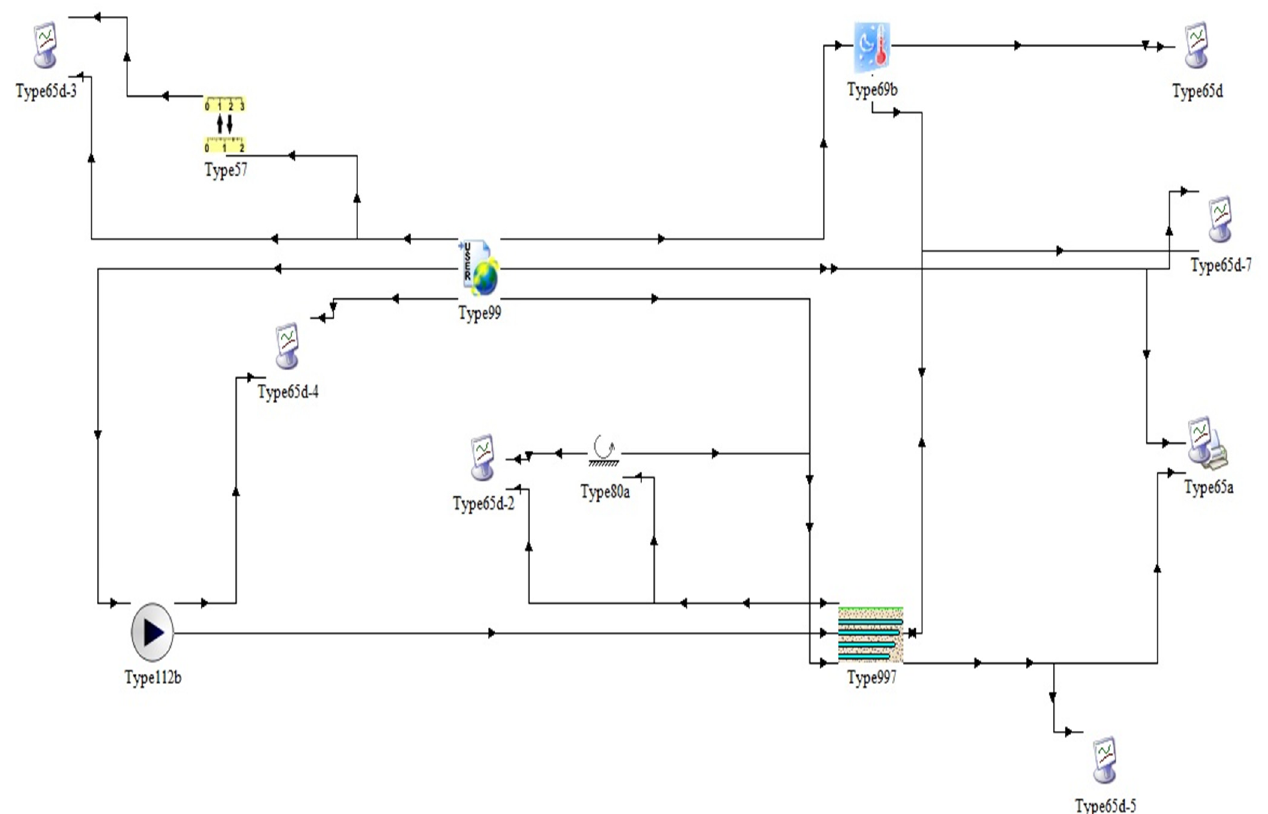
Figure 8. TRNSYS soil performance model.